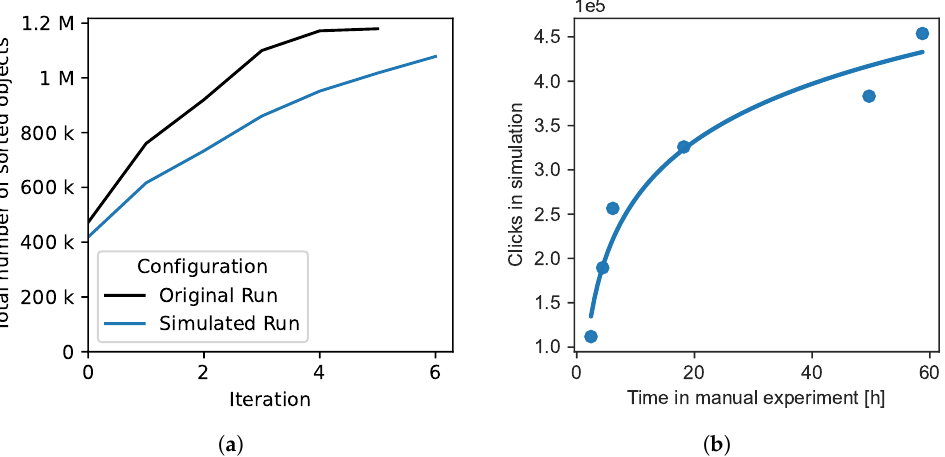
Figure 3. Comparison of original and simulated annotation, based on the UVP5/MorphoCluster labels generated in MC20. ( a ) Total number of sorted objects; ( b ) Correspondence between number of simulated clicks and time required for manual